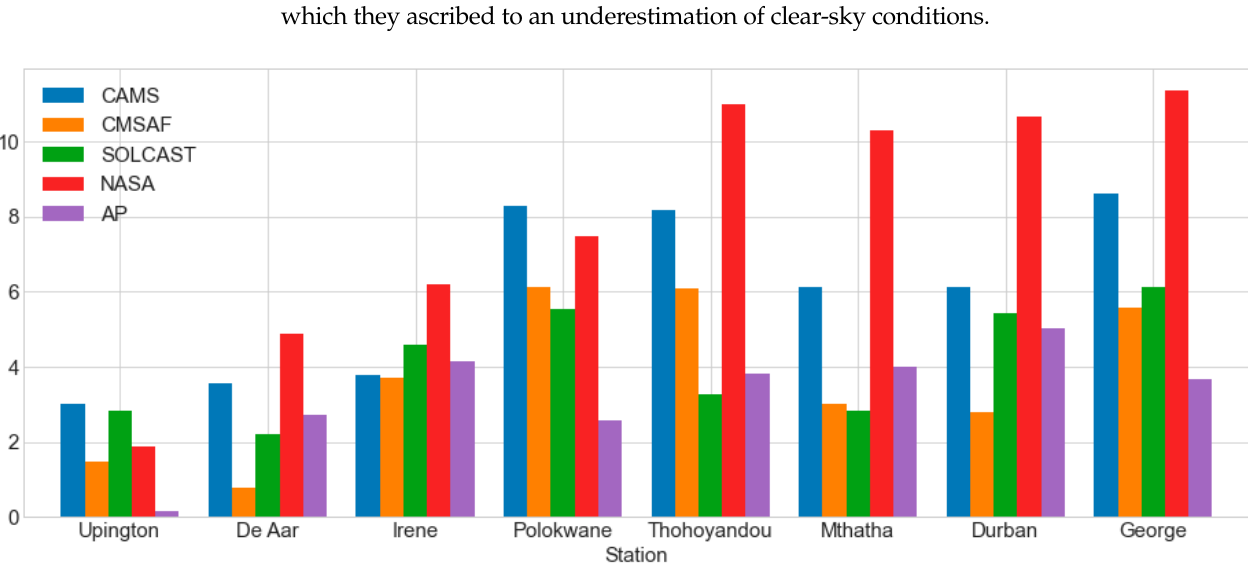
Figure 14. The daily rRMSE of the estimated GHI datasets for overcast sky minus all-sky conditions.